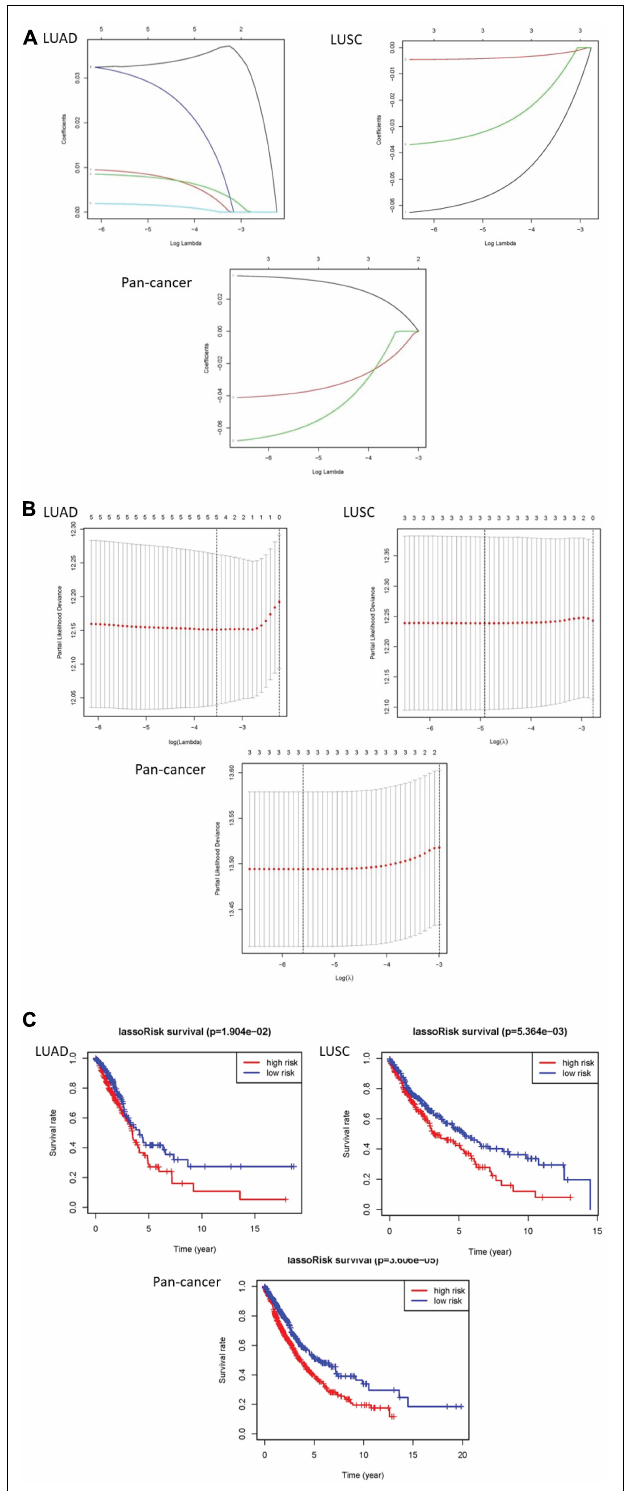
FIGURE 4 | The results of LASSO Cox regression algorithm and survival curves. (A,B) Show coefficient results derived from LASSO Cox regression algorithm. (C) There are distinct differences of overall survival curves in the high-risk group and low-risk group which are distributed by risk score.